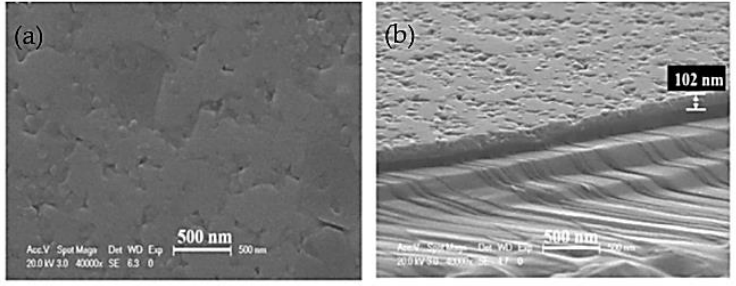
Figure 26. Bi 2 Fe 4 O 9 film: ( a ) topology; ( b ) cross – section [82].